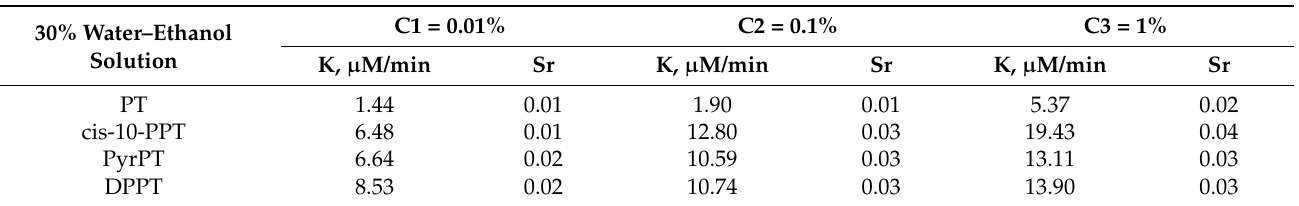
Table 3. Values of the antioxidant activity of phenothiazine and its derivatives in 30% water– ethanol solution.